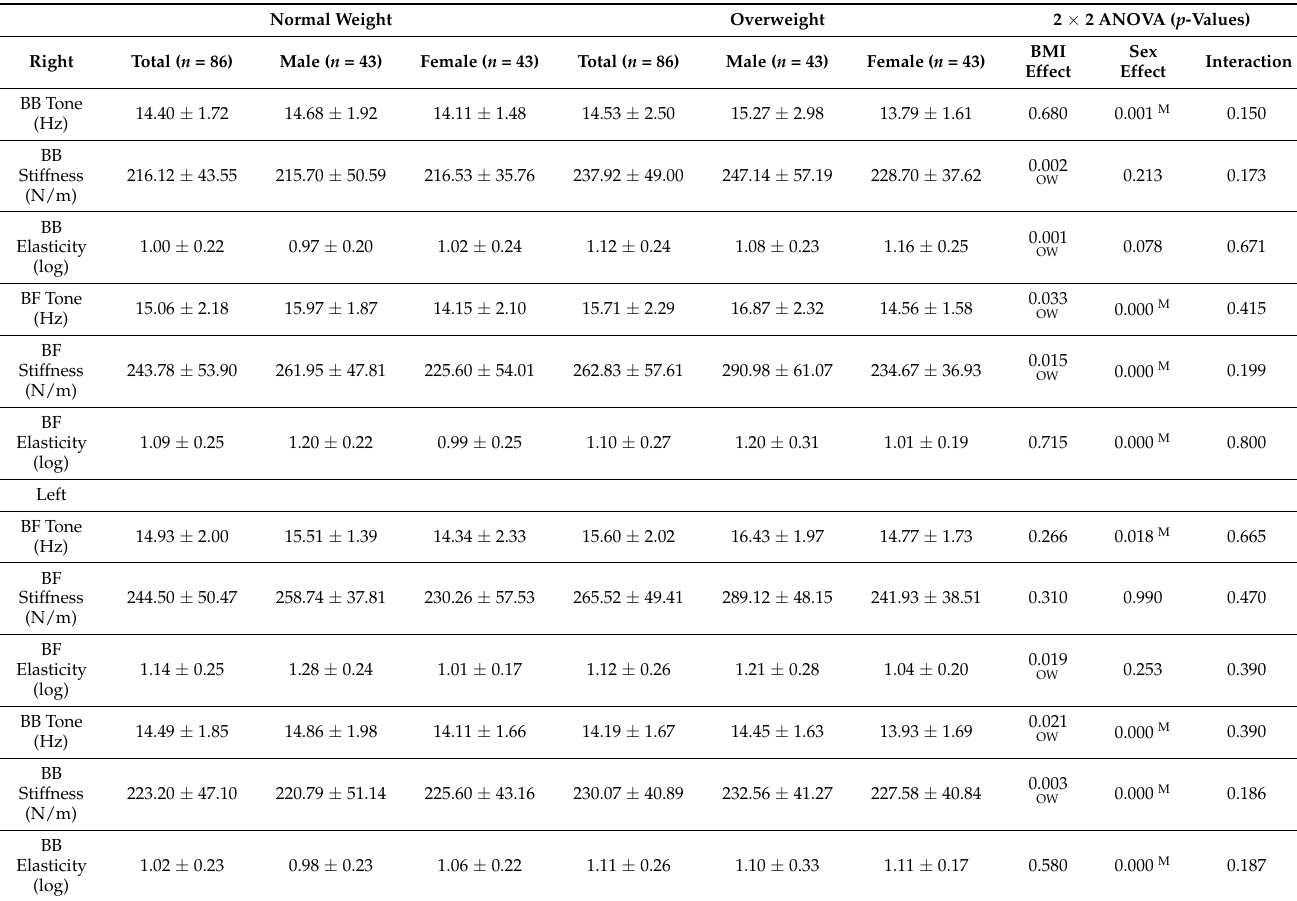
Table 4. Comparison of viscoelastic properties in BMI